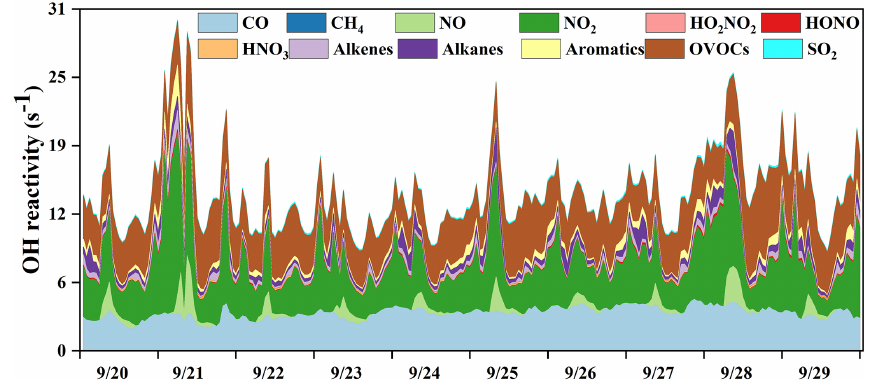
Figure 4. Time series of model-calculated OH reactivity and its partitioning to the major reactants in Xiamen during 20–29 September 2019.